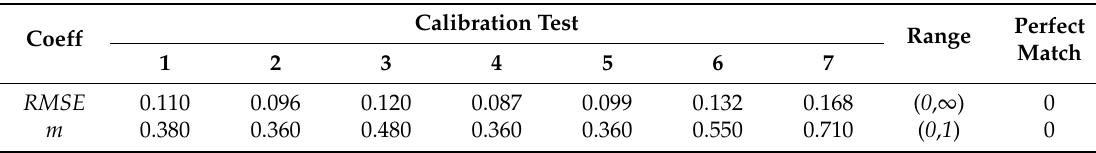
Table 3. Calculated coefficients for each calibration test.